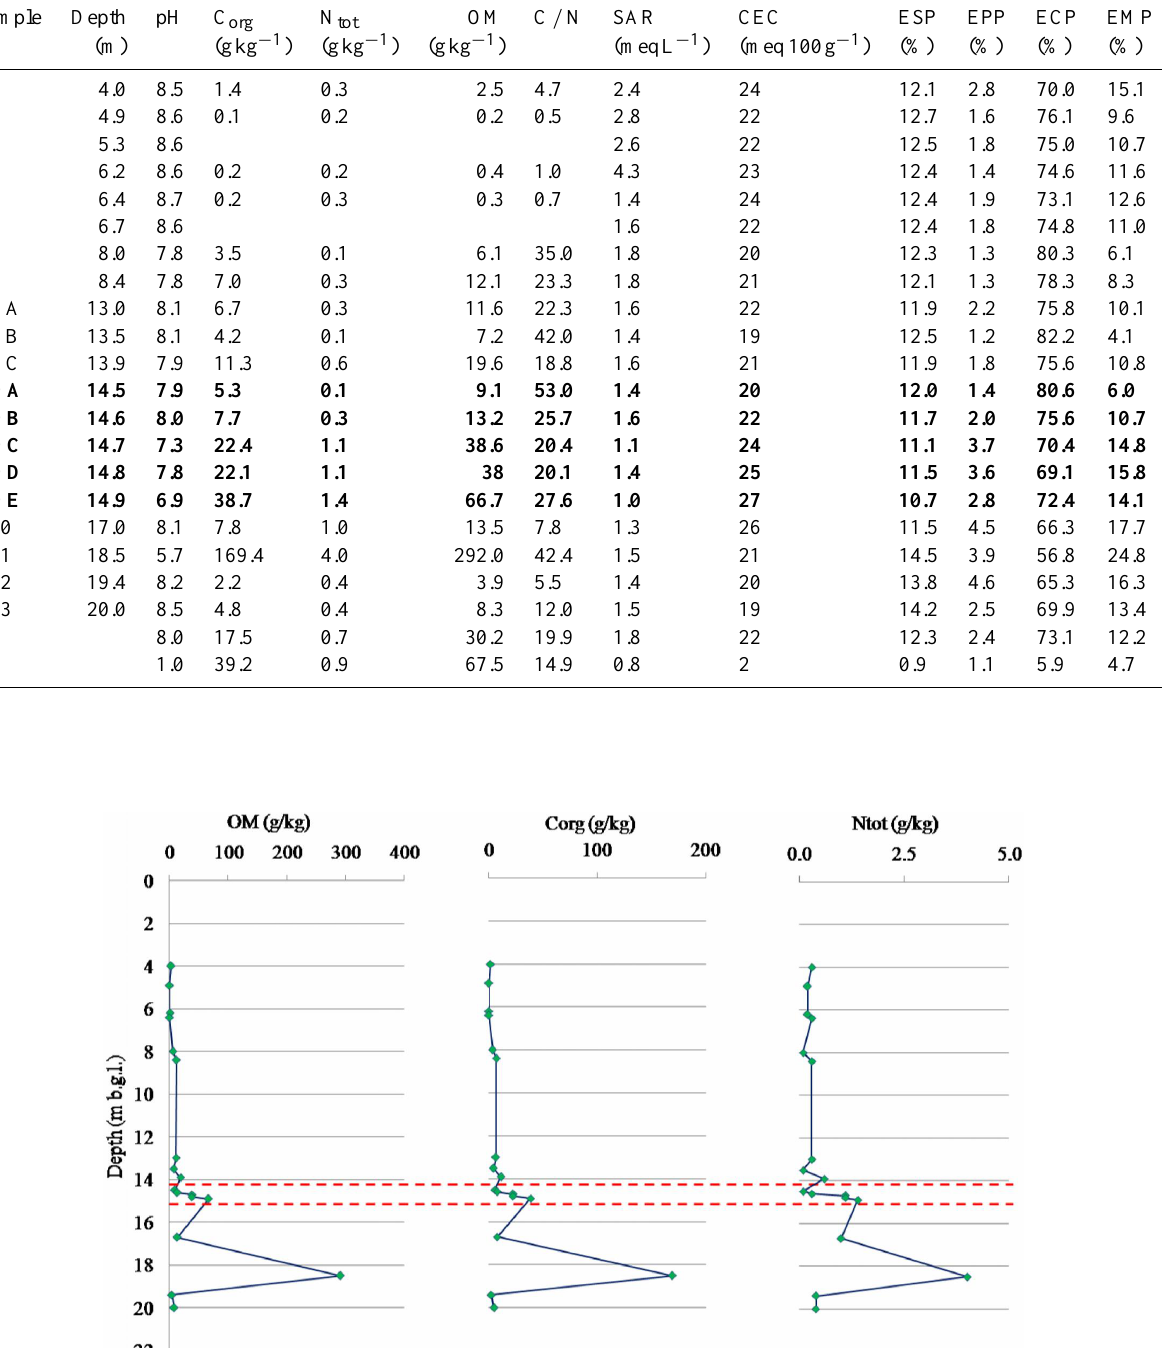
Table 3. Chemical composition of analysed samples (C org = organic carbon; N tot = total nitrogen; OM = organic matter; C / N = C / N ra- tios; SAR = sodium adsorption ratio; CEC = cation exchange capacity; ESP = exchangeable sodium percentage; EPP = exchangeable potas- sium percentage; ECP = exchangeable calcium percentage; EMP = exchangeable magnesium percentage). Slip zone samples are reported in bold.